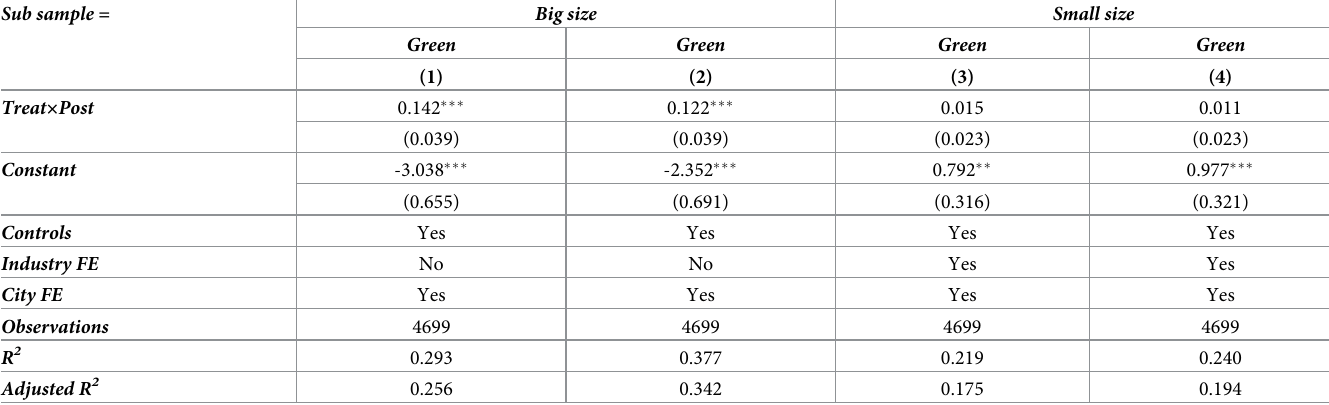
Table 9. Heterogeneity regression results by firm